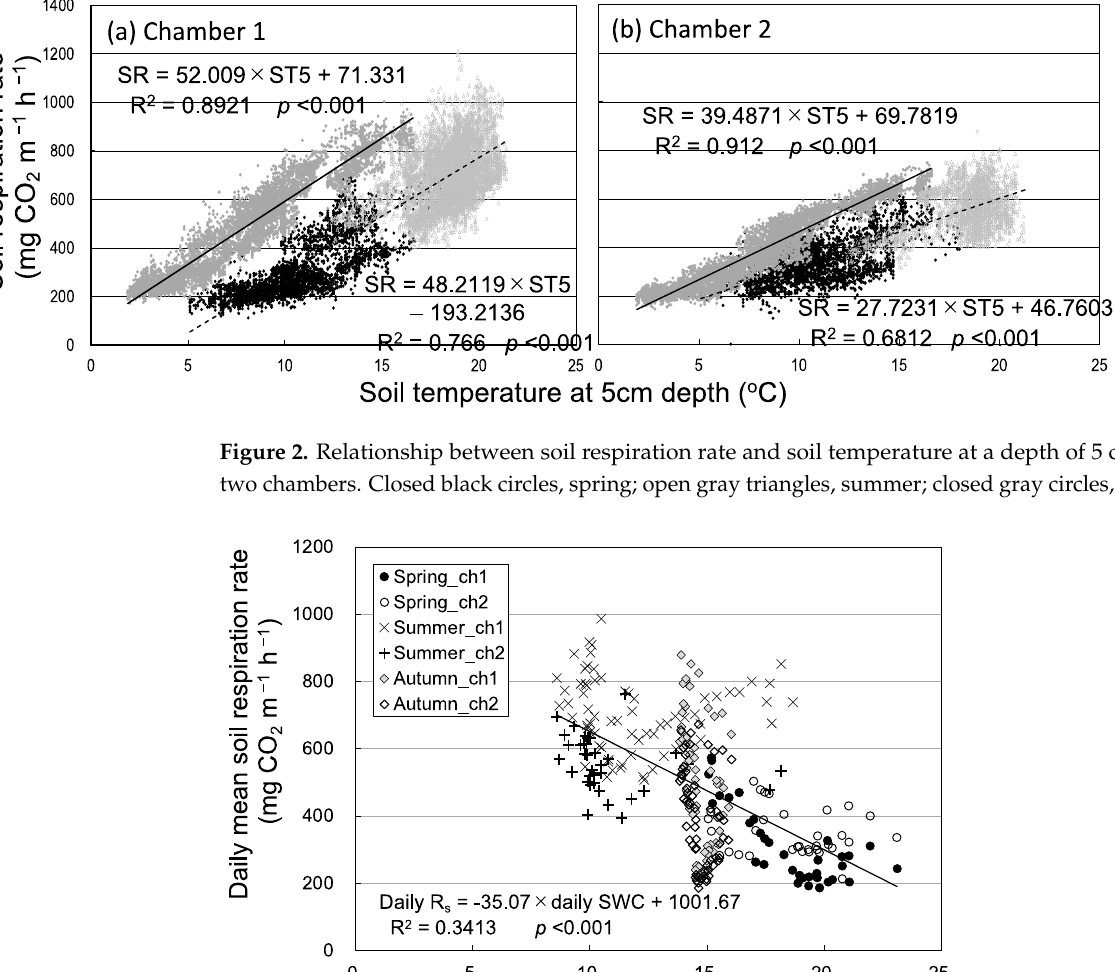
Figure 1. Seasonal variation in soil respiration and environmental factors during ( a ) spring, ( b ) sum- mer, and ( c ) autumn 2018. SR_1 and SR_2, R s in two chambers of R s ; ST, soil temperature at a depth of 5 cm; SWC, soil water content at a depth of 10 cm.